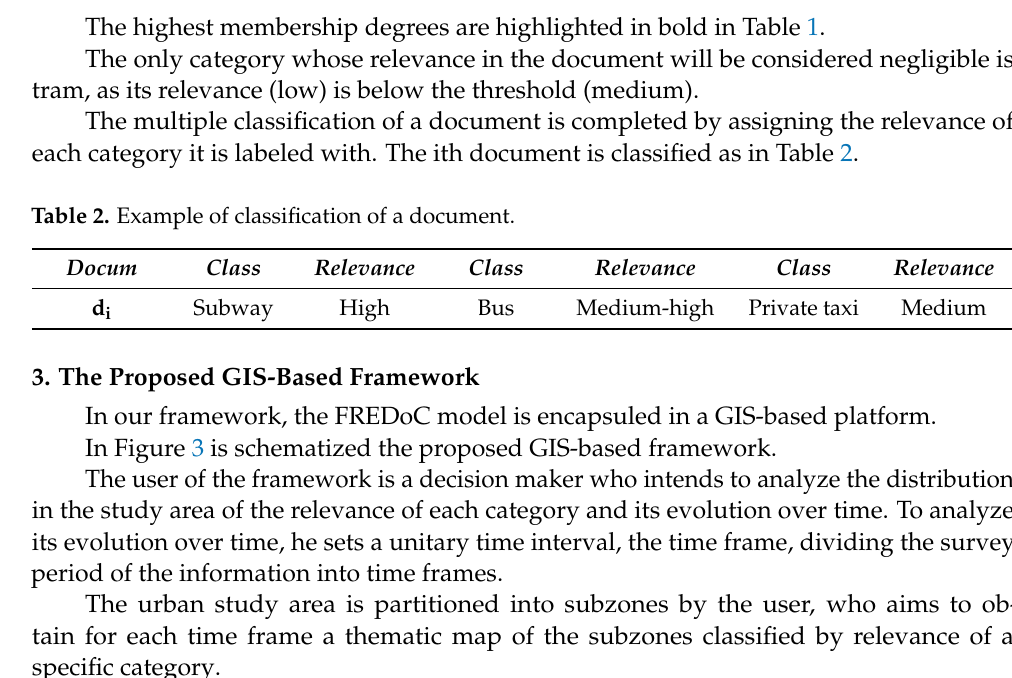
Table 2. Example of classification of a document.